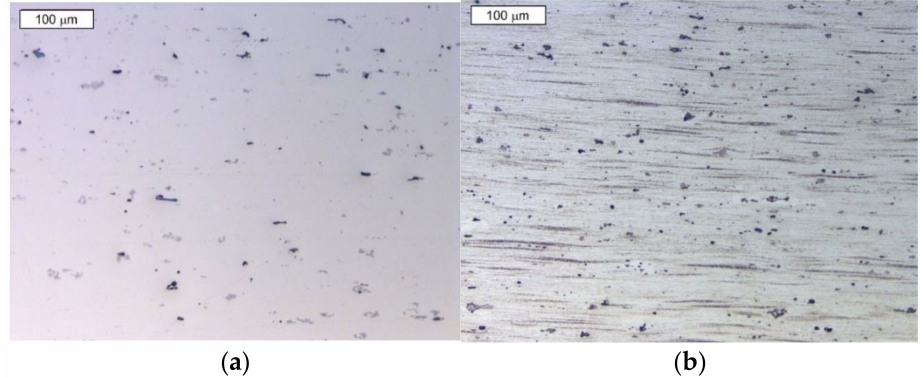
Figure 9. Microstructure of the alloy in the RRA state: ( a ) unetched state and ( b ) etched state. Light microscopy, BF.